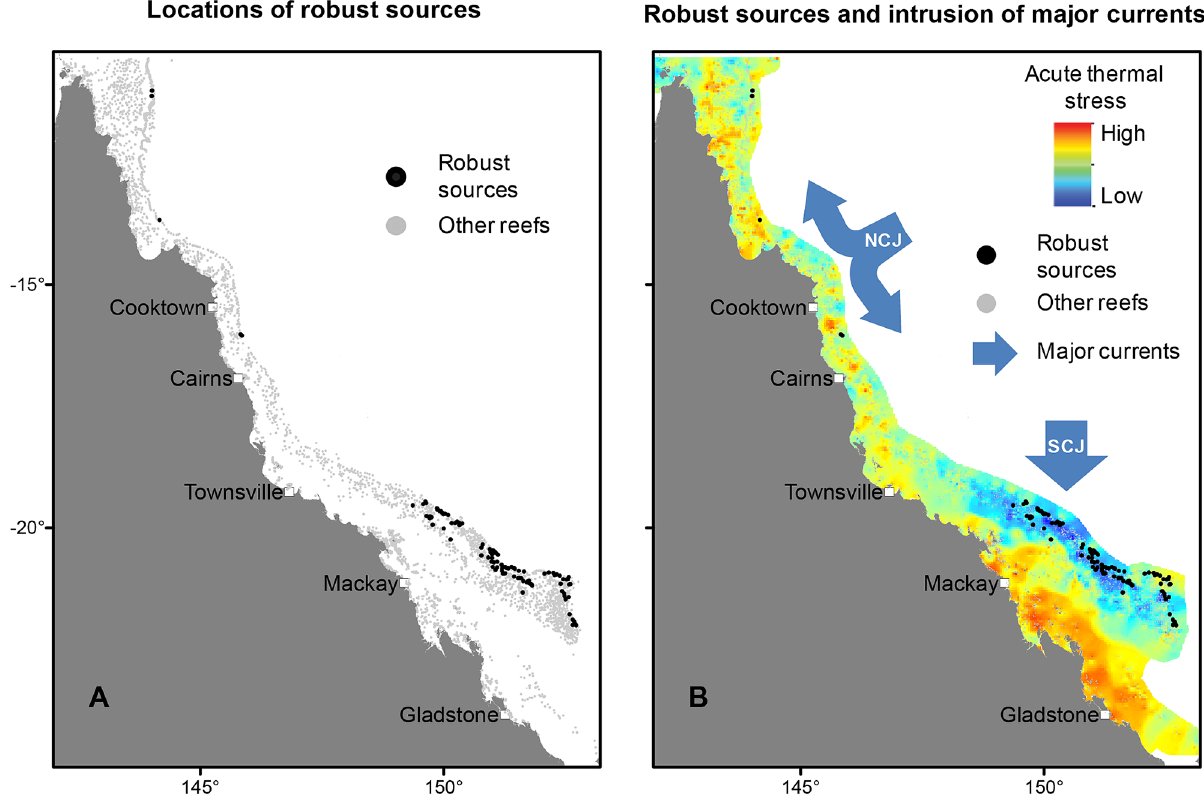
Fig 4. Identifying robust sources on the GBR. (A) Robust sources are the reefs that possess high replenishment potentialwhilealso having low risk of bleaching and COTS outbreaks. (B) When robust sources are superimposed on estimates of acute thermal stress, the regionof lower stress in the southernGBR is clearly visible. Most robust sources are locatedin a regionwhere cooler oceanicwater of the SCJ, and to a lesser extent the NCJ, of the South EquatorialCurrent flushes the GBR reef matrix [35]. Data provided in S1 Data. COTS, crown-of-thorns starfish; GBR, Great Barrier Reef; NCJ, North CaledonianJet; SCJ, South Caledonian